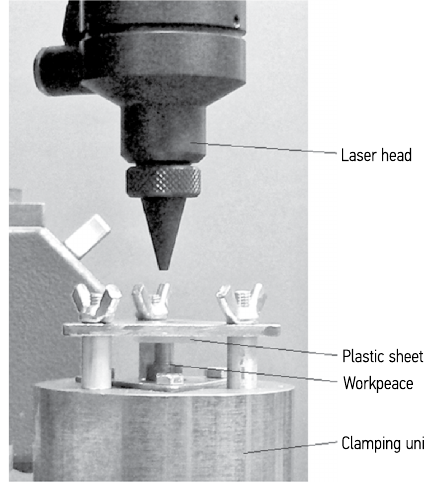
Fig. 2. Photo of experimental setup (source: own